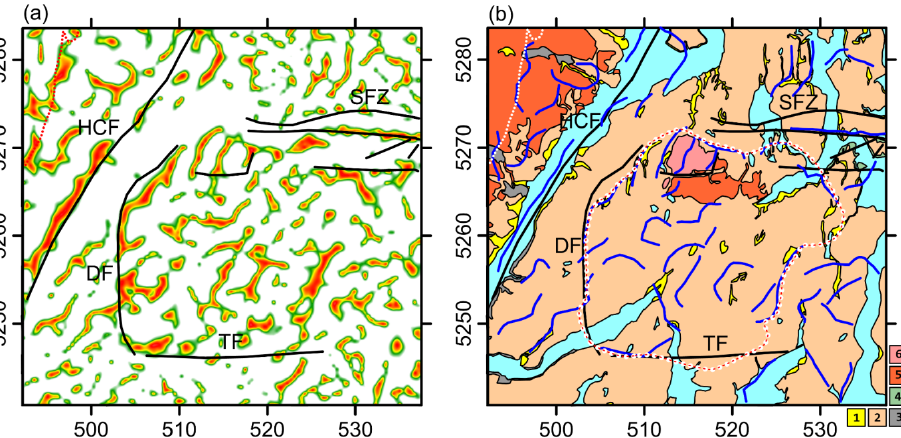
Figure 11. ( a ) Structural mapping of the Seattle Uplift (SU), Washington, United States of America using the proposed ETG filter; ( b ) The magnetic lineaments (solid blue lines) are detected by the ETG method and the geological structures are represented in solid black lines.